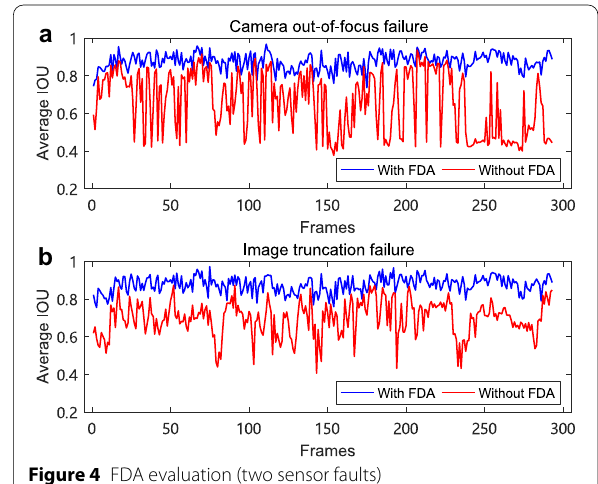
Figure 4 FDA evaluation (two sensor faults)